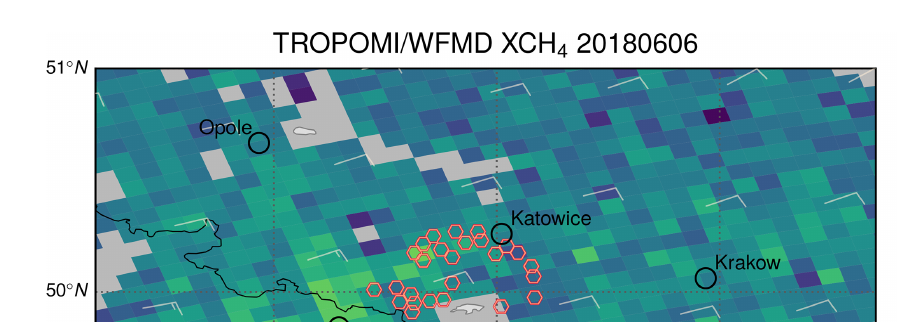
adsorbed at coal grains. For safety reasons, the coal mine methane is diluted with air below the explosive range and released through ventilation shafts to the